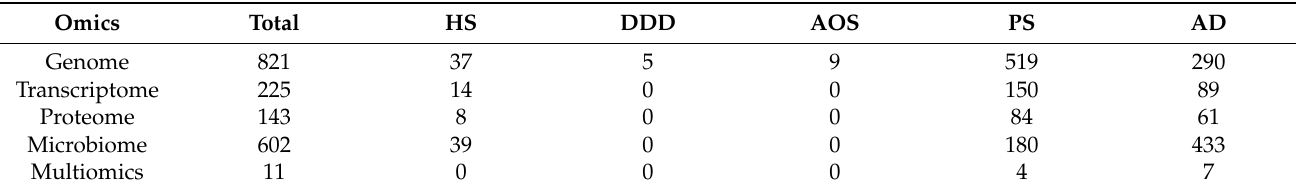
Table 1. Scientific publications from 2016 to 2020 on Notch dermatological diseases, excluding bibliographic reviews and meta-analyses.